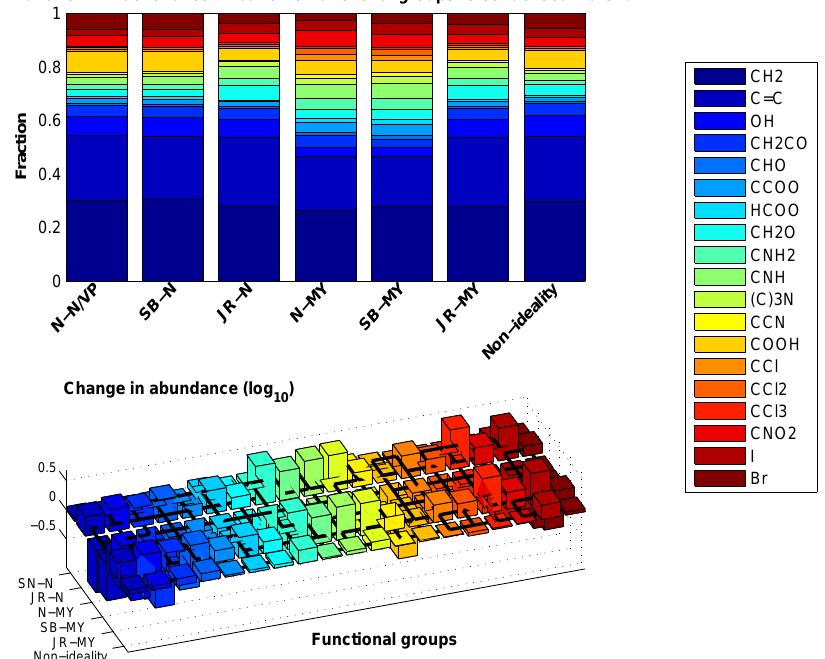
Fig. 11. Variation in fractional contribution to condensed material (top) and change in molecular abundance in the condensed phase (bottom) of each of the main UNIFAC functional groupings shown in Table 1, dependent on the property predictive technique used in the partitioning model. Ambient conditions were chosen to be T=298.15K and RH=90%.